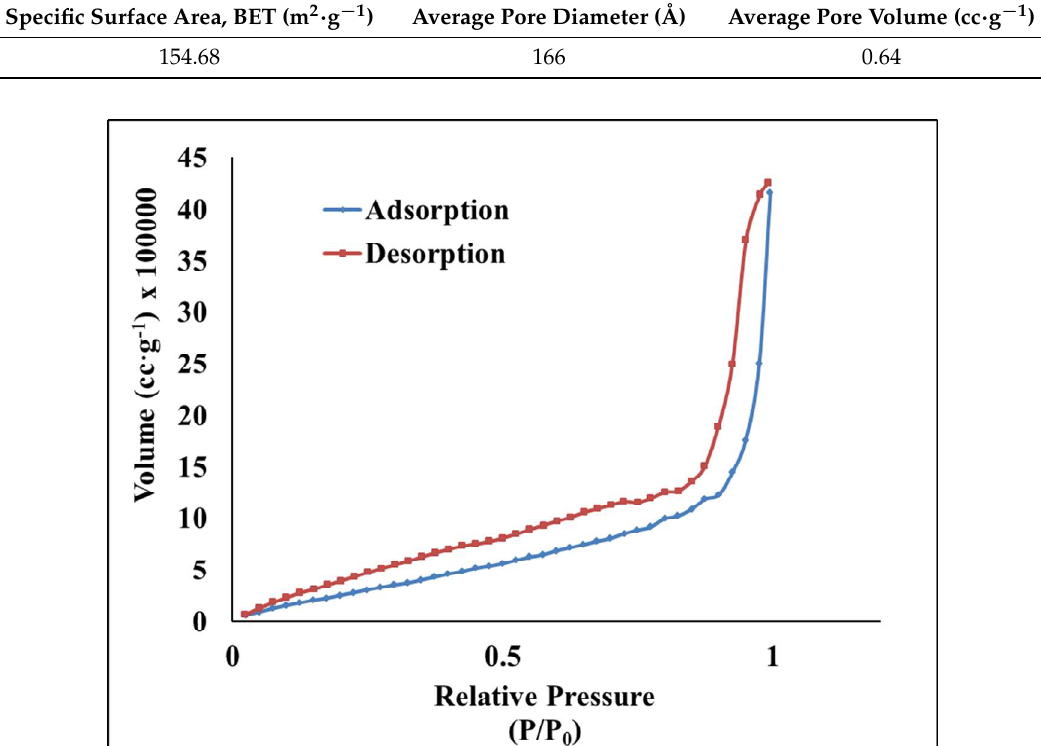
Table 1. Porous properties of the SWNHs monolithic solid.